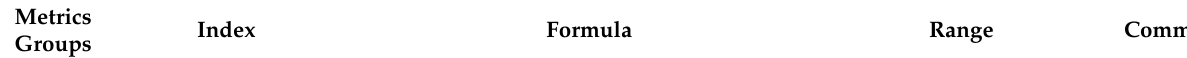
Table A1. Brief description of landscape index in this research (refer Fragstat 4.2 help document